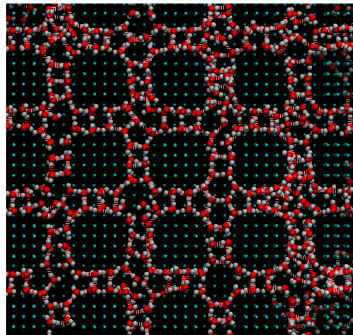
Figure 13. Snapshot of the two-dimensional structure of water observed in a nanostructured surface with ε = 19.74. kJ/mol.